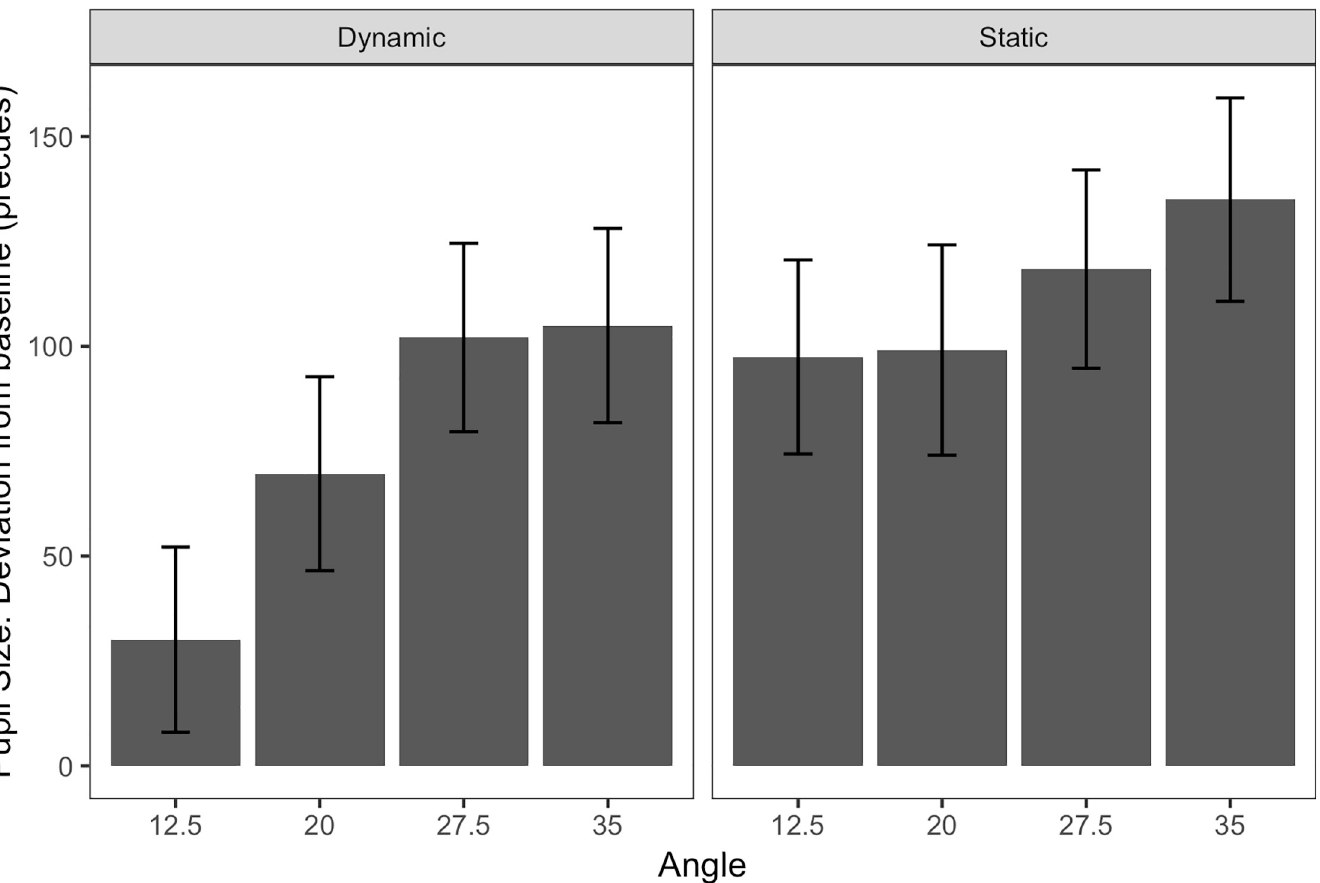
Fig 4. Mean pupil size deviations from the baseline per angle when comparing the starting points of the moving stimuli in the dynamic mode with the respective angle of the non-moving stimuli in the static mode. Error bars provide 95% confidence